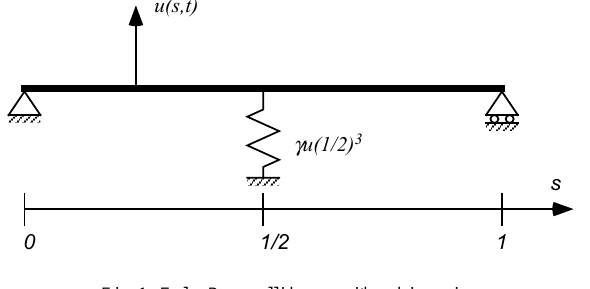
Fig. 1. Euler Bernoulli beam with cubic